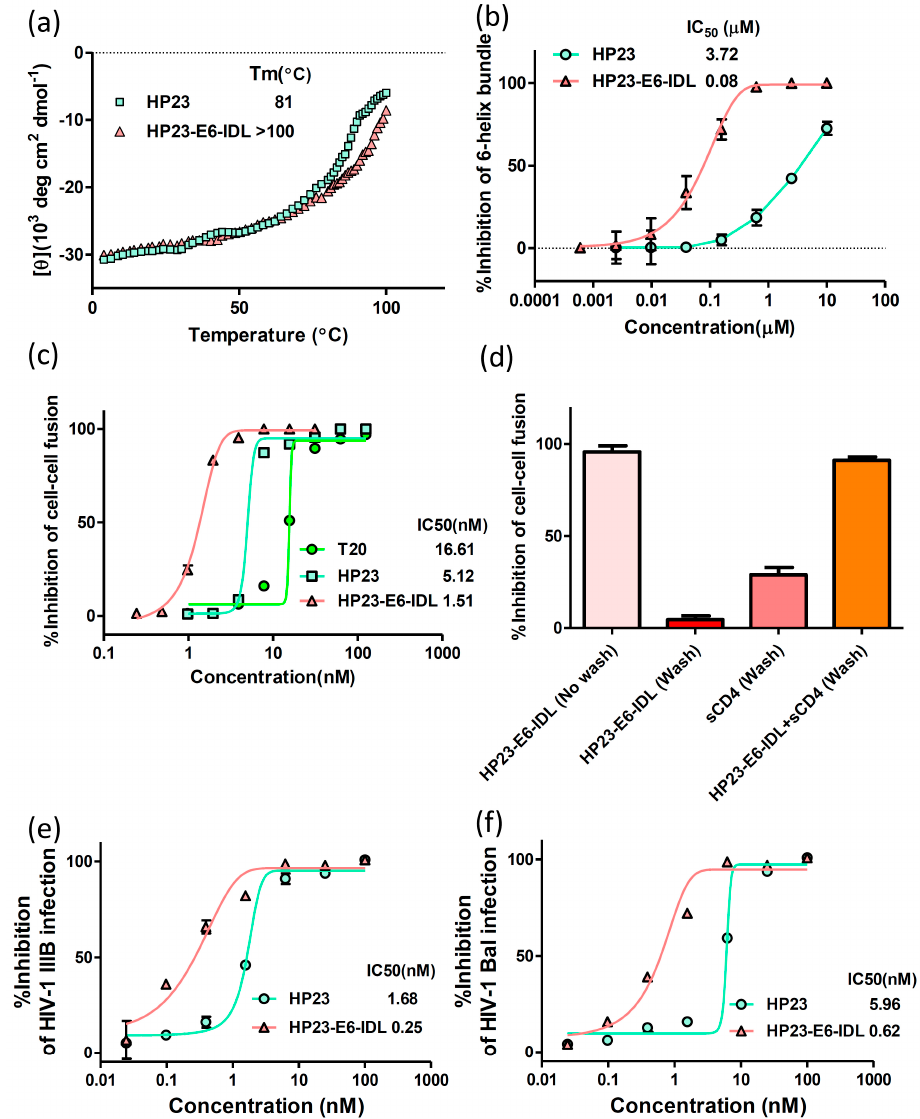
Figure 3. Inhibitory activity of HP23-E6-IDL. ( a ) Comparison of melting curves of the complexes formed by N46 and HP23 or HP23-E6-IDL. HP23-E6-IDL shows better thermostability; ( b ) Inhibitory activities of HP23 and HP23-E6-IDL against 6-HB formation between N46 and C34; ( c ) Inhibitory activities of peptides against cell–cell fusion between H9/HIV-1IIIB cells and MT-2 cells; ( d ) An HIV-1 Env-mediated cell–cell fusion washout assay was performed to determine the Env engagement of CD4-receptor in the HP23-E6-IDL-mediated inhibition of HIV-1 entry. Inhibition rates were as follows: HP23-E6-IDL alone without wash, 95.8%; HP23-E6-IDL alone with wash, 4.6%; sCD4 alone with wash, 28.9%; HP23-E6-IDL and sCD4 with wash, 91.1%; ( e ) Inhibitory activities of HP23 and HP23-E6-IDL against HIV-1 IIIB (X4 virus) infection; ( f ) Inhibitory activities of HP23 and HP23-E6-IDL against HIV-1 Bal (R5 virus) infection. Error bars in this figure show standard